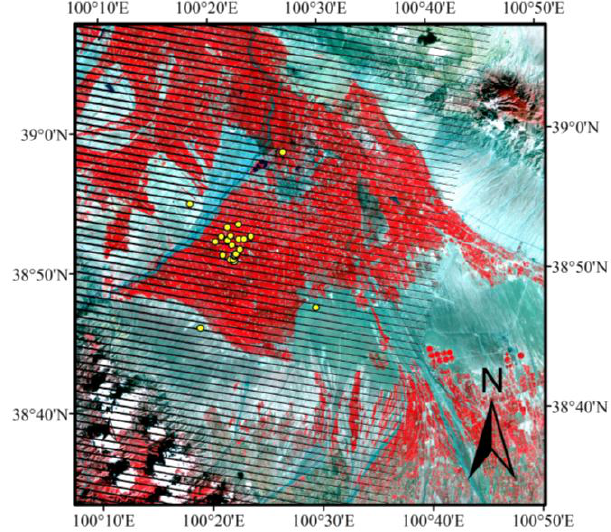
Figure 3. The geographic location of the Heihe test area. The yellow points represent the location of sample plots.